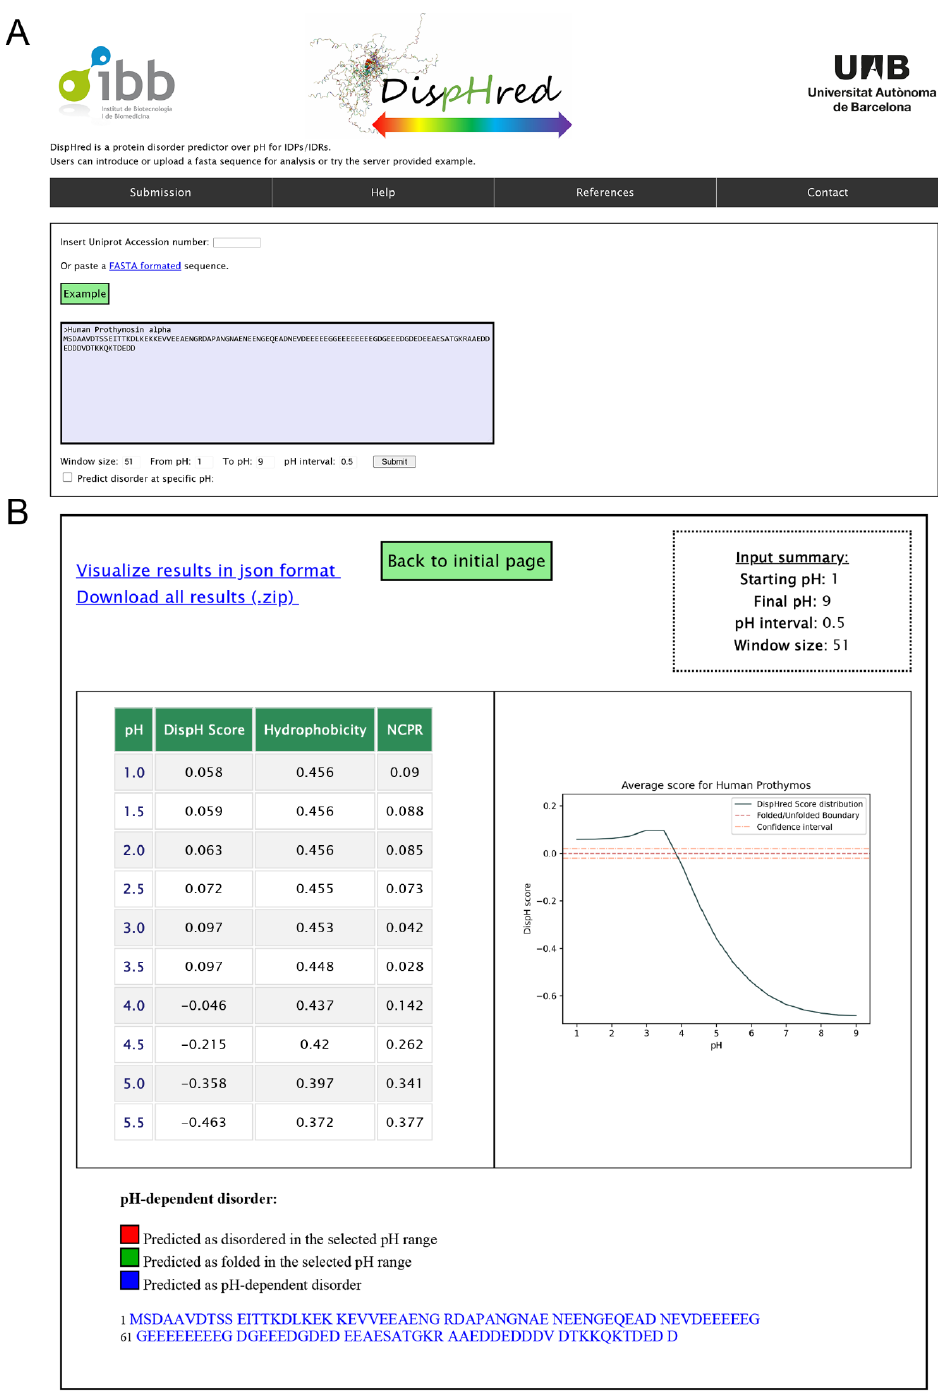
Figure 3. DispHred web server interface. ( A ) Web input page. The user can paste their sequence or insert a valid Uniprot Accession number. DispHred works by default by checking disorder in a range of pHs but allows users to test values at a specific pH. By default, a 51-residue sliding window is populated, but users can personalize its length. ( B ) Web results page for a selected range of pHs. Two clickable links appear on the upper left part of the screen with a JSON file or a ZIP file containing DispHred calculations and generated figures. On the lower left part, the table shows the DispHred, hydrophobicity, and NCPR average scores for each pH. Clicking each pH will open a figure representing the Dis pH score variation along the sequence for the selected pH. On the lower right part, a figure representing the Dis pH average score for each pH is shown. Scores above the red dashed line indicate predicted order. On the bottom of the screen, folded, disordered, and conditionally disordered regions are indicated in the sequence in green, red and blue,